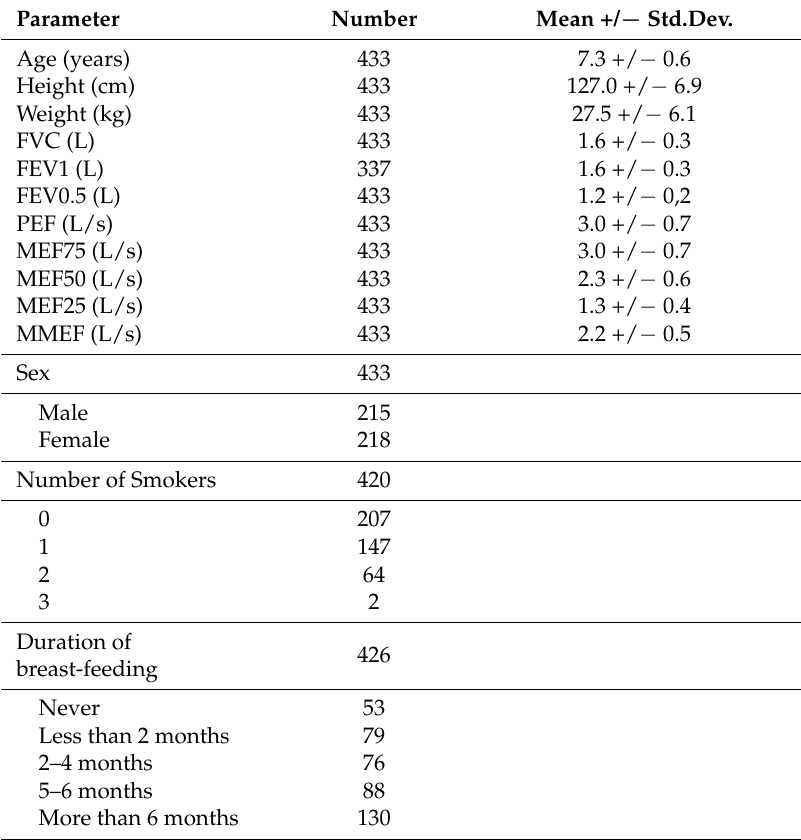
Table 1. Description of the